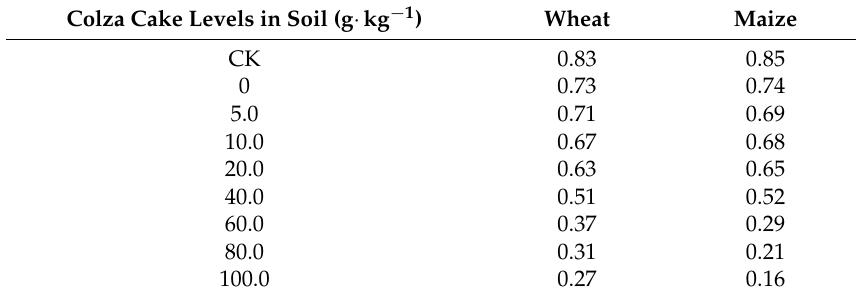
Table 3. The calculated ratio ( R ) values of the DGT-measured concentrations ( C DGT ) of Cd to soil solution concentrations ( C sol ) of Cd with increasing addition of colza cake in